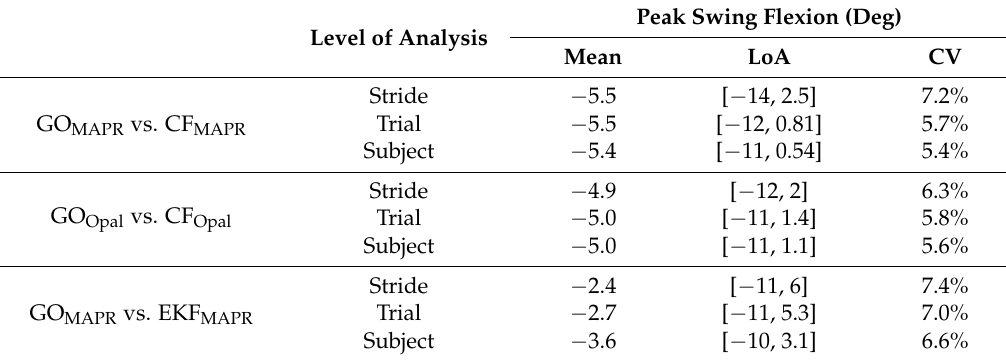
GO MAPR vs. EKF MAPR